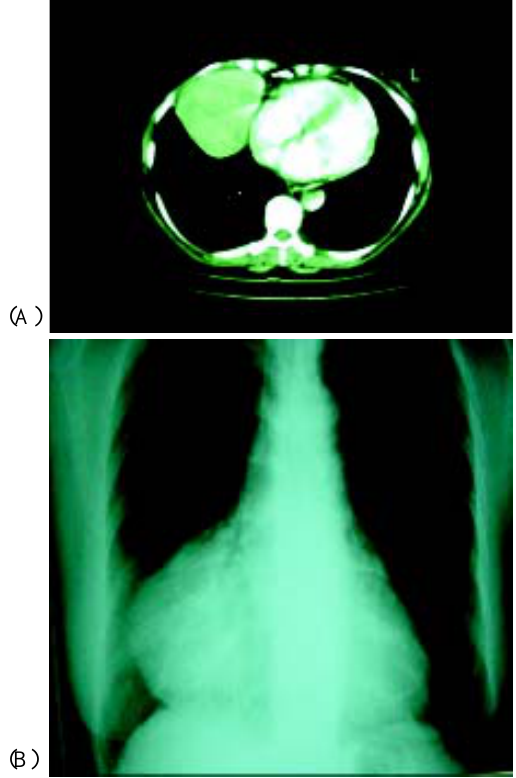
Fig. 2 - (A)Tomografia computadorizada e (B)radiografia de tórax